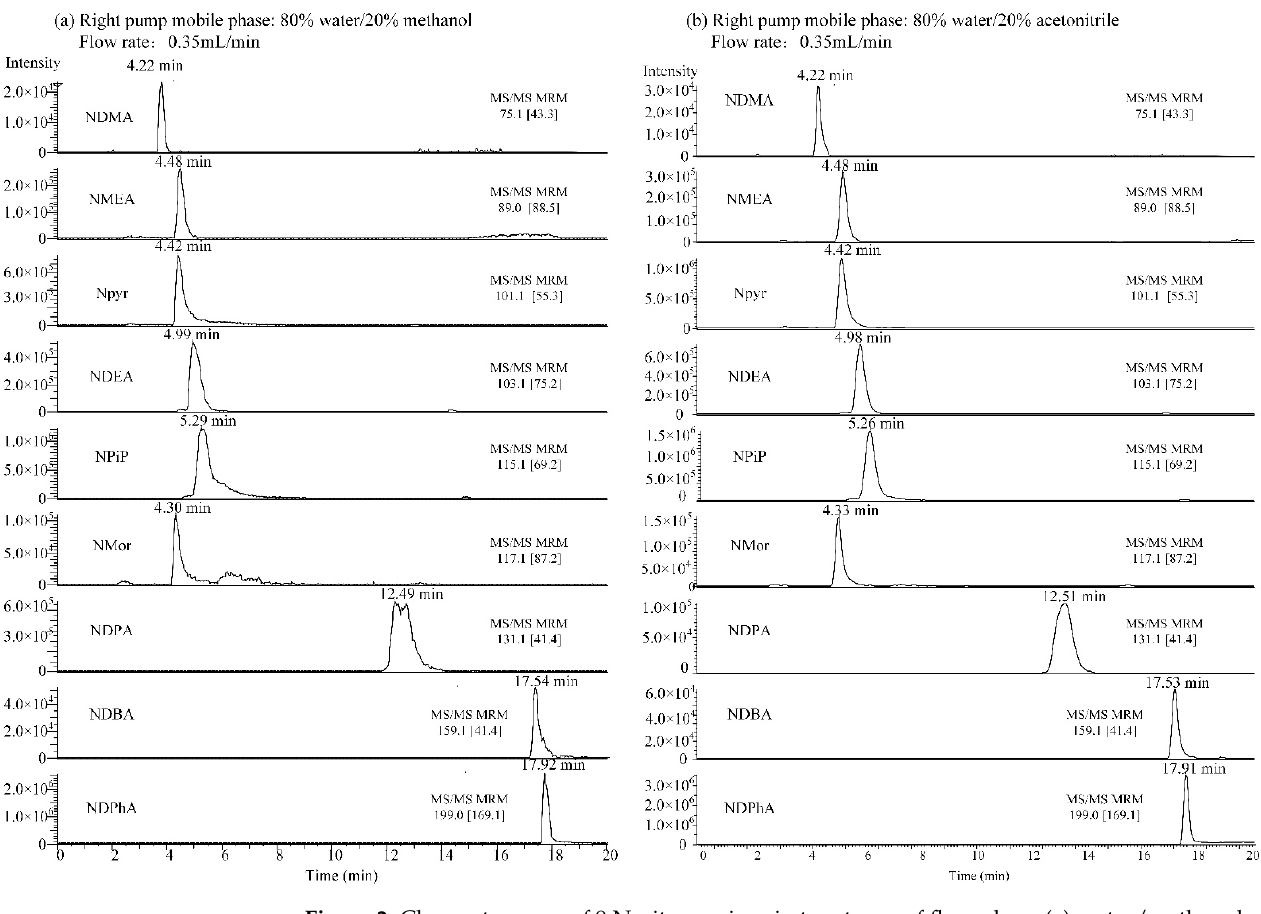
Figure 2. Chromatograms of 9 N-nitrosamines in two types of flow phase ( a ) water/methanol and ( b ) water/acetonitrile. Table 2. Elution procedure for left and right pumps and six-way valve switching